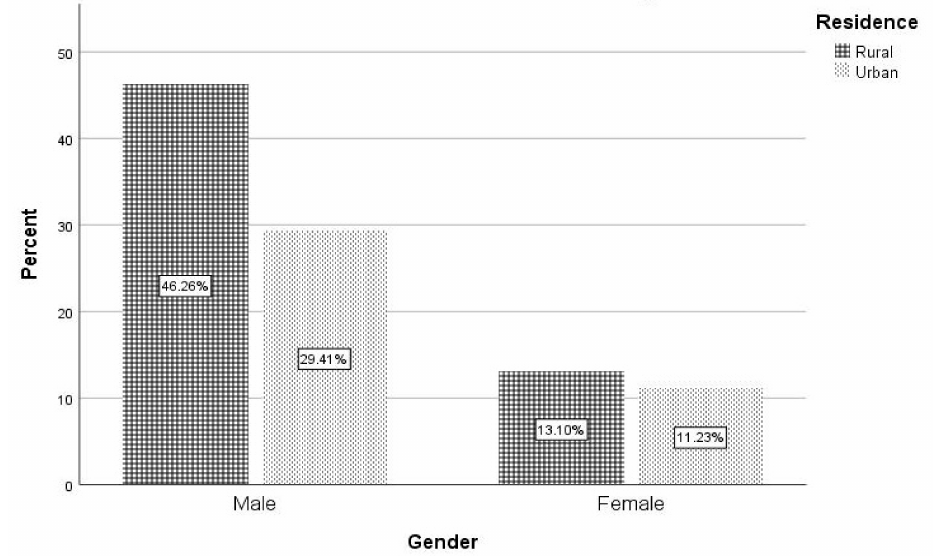
Figure 1. Survey participants (%) by gender and residence (urban vs. rural). Fifty-nine percent of the total population resides in rural areas (towns with less than 10,000 people). Most people in rural areas work in agriculture and have a low level of education compared to urban areas.